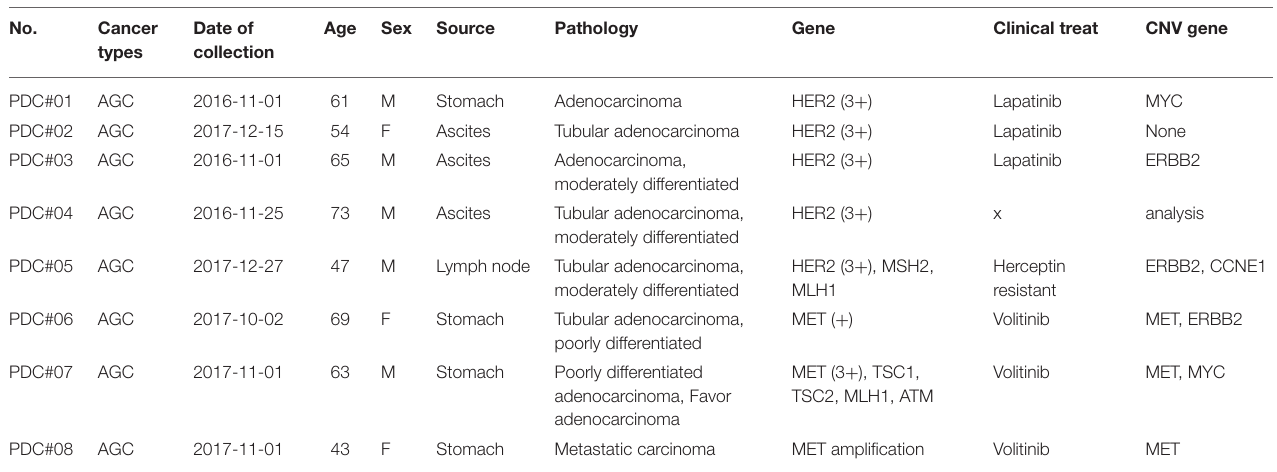
FIGURE 1 | (B) Demonstration of proficient EpCAM expression and deficient vimentin expression in five gastric cancer cell lines (AGS, KATO-III, MKN-45, NCI-N87, SNU-216). DAPI (nuclear blue fluorescent label) was stained to label cell nuclei. EpCAM and vimentin expression levels are depicted as fluorescence intensities (relative fluorescence units, RFU). Demonstration of significantly different expressions of EpCAM and vimentin in five gastric cell lines. Fluorescence intensities of EpCAM and vimentin were measured; EpCAM expression intensity increased when the concentrations of tumor cells proportionately increased. TABLE 1 | Baseline clinical features of patient-derived cancer cells.